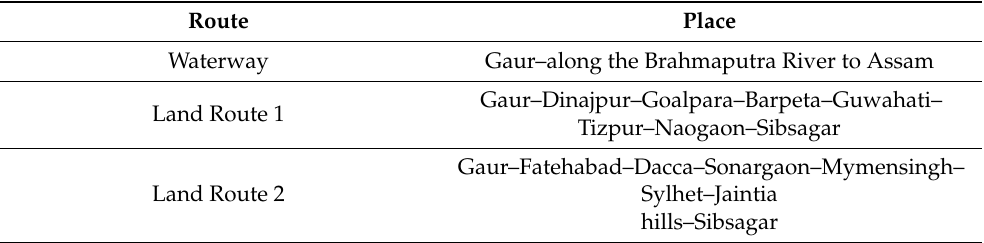
Table 3. Inferred routes from Bengal to Assam (16th to the mid-18th century). Source: the authors; Reference: [76].